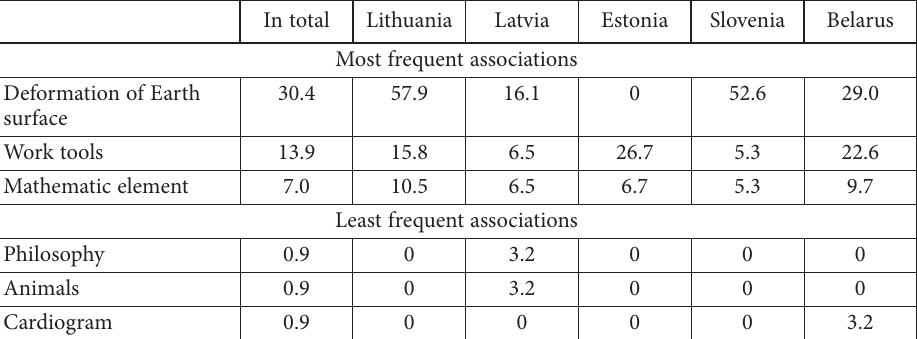
given fragment (Tables 1, 2). Table 1. Associations of Fragment 1 (%) (source: created by authors) In